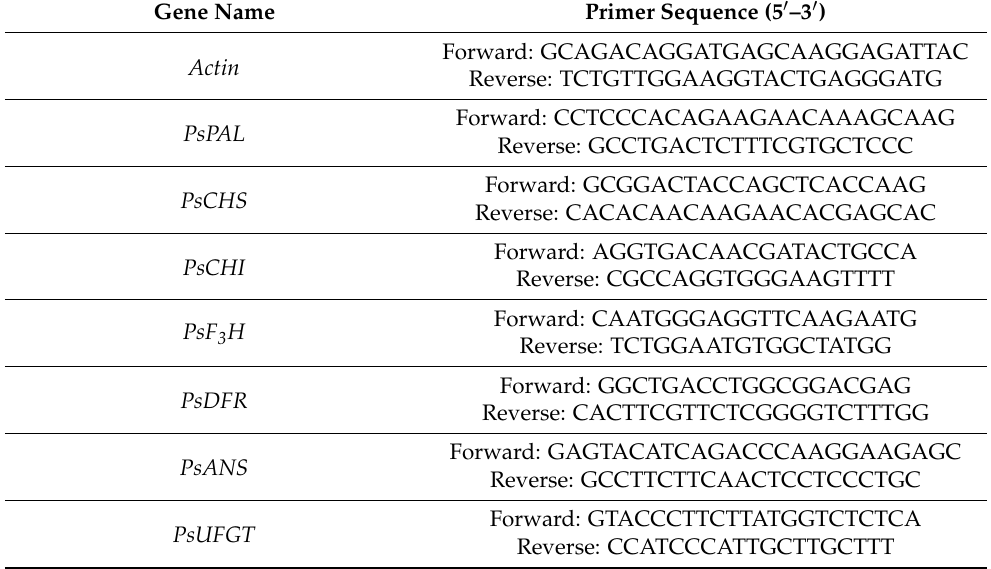
Table 1. Target genes analyzed by